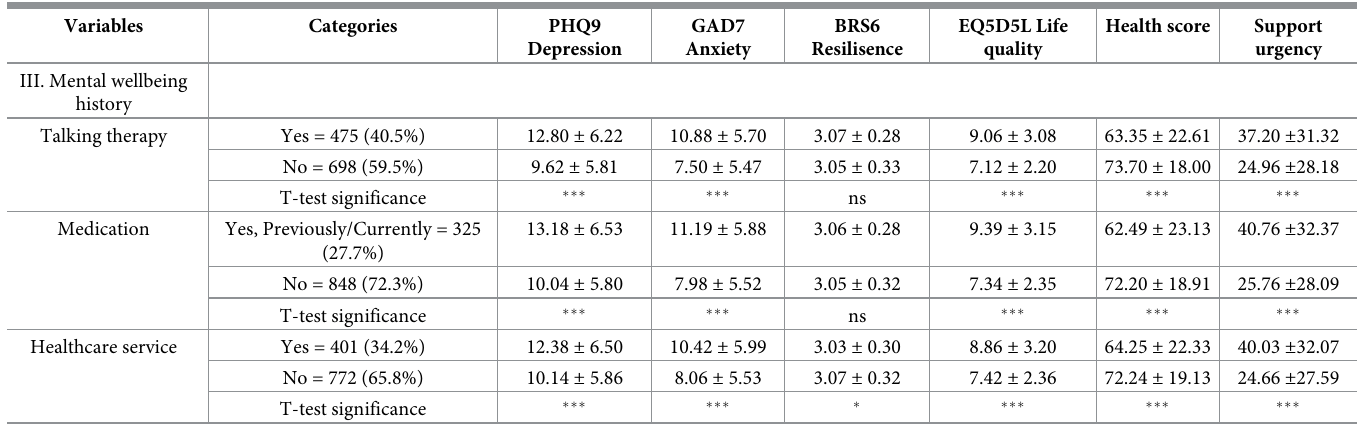
Table 8. Bivariate analysis on brief mental wellbeing history.